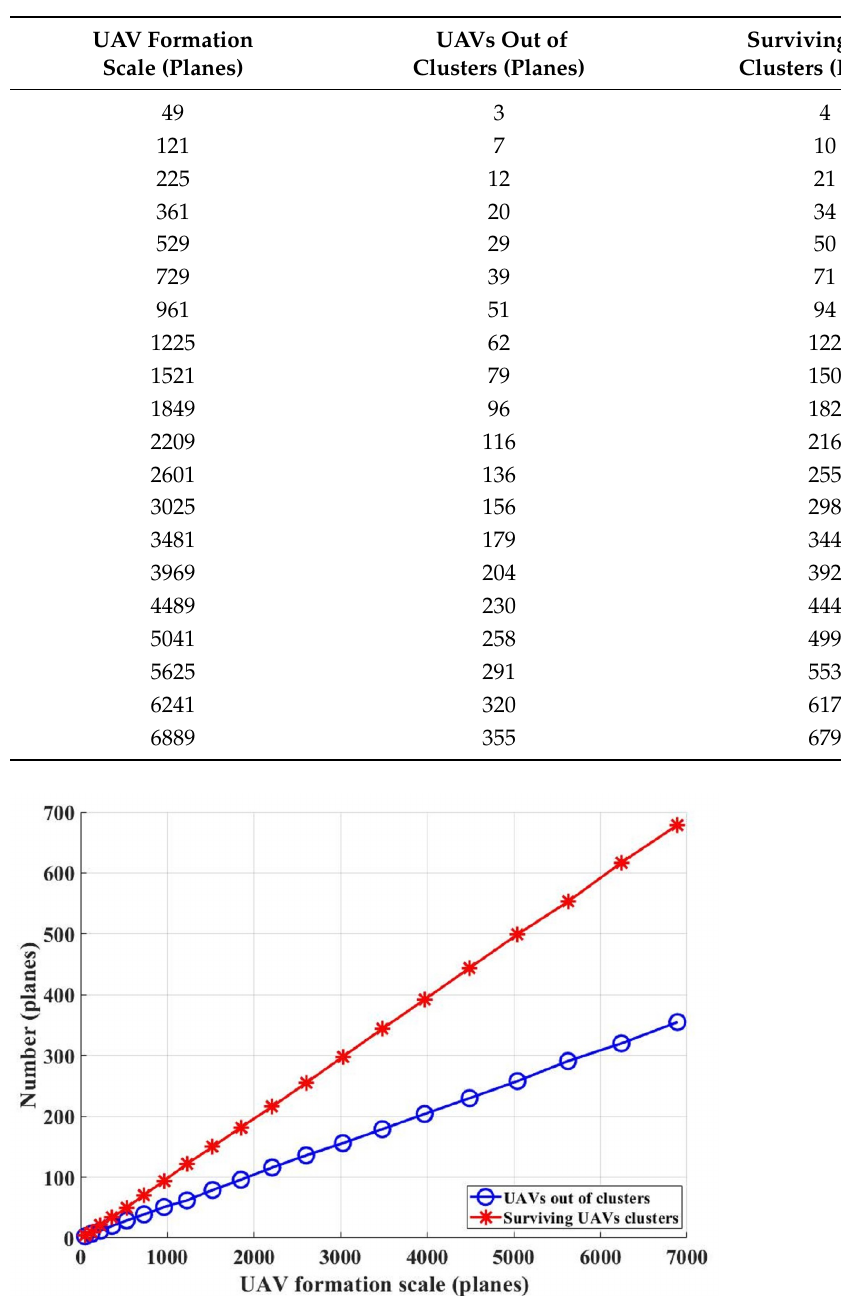
Figure 26. UAVs out of clusters and surviving UAVs in different-scale formations with the fight loss set at